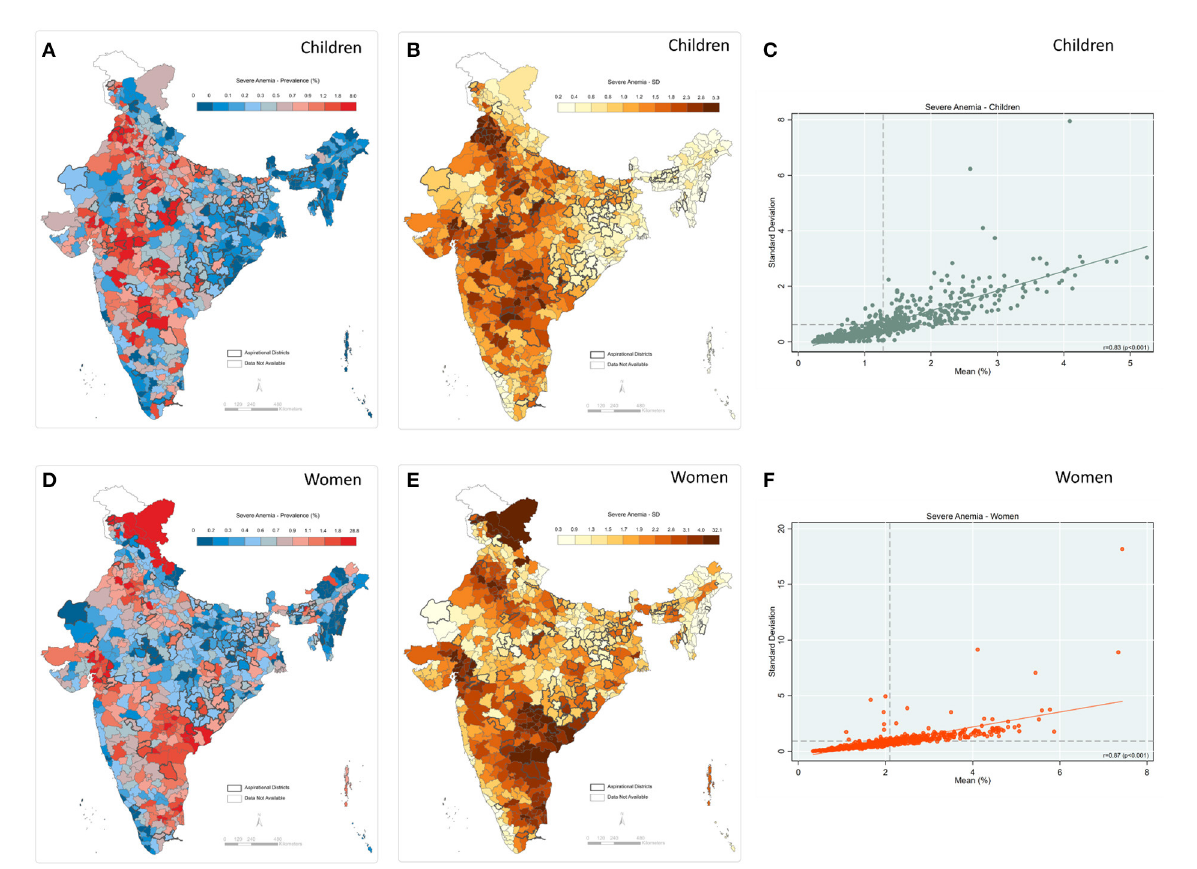
FIGURE5 Severe anemia (A) Map-district-level prevalence for children; (B) Map-inter-cluster SD for children; (C) Scatter-prevalence vs. SD for children; (D) Map-district-level prevalence for women; (E) Map-inter-cluster SD for women; (F) Scatter-prevalence vs. SD for women, India, NFHS